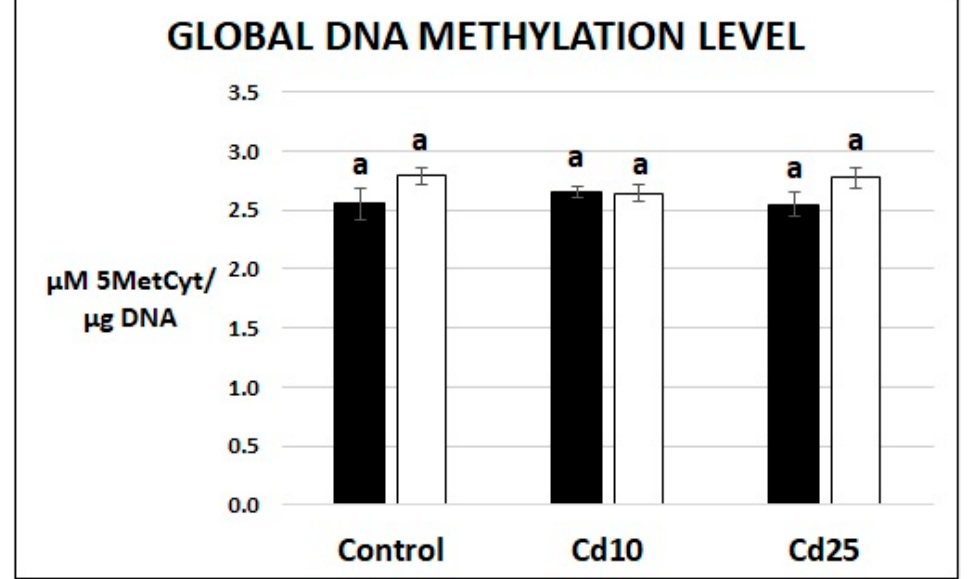
Figure 8. The level of global methylation in seedlings after 48 h of Cd stress (black bars) and after 7 days of recovery period (white bars). Results are the means of three independent experiments ± SE . Results showing no statistically significant differences in relation to control by p = 0.05 are marked with the same letter.